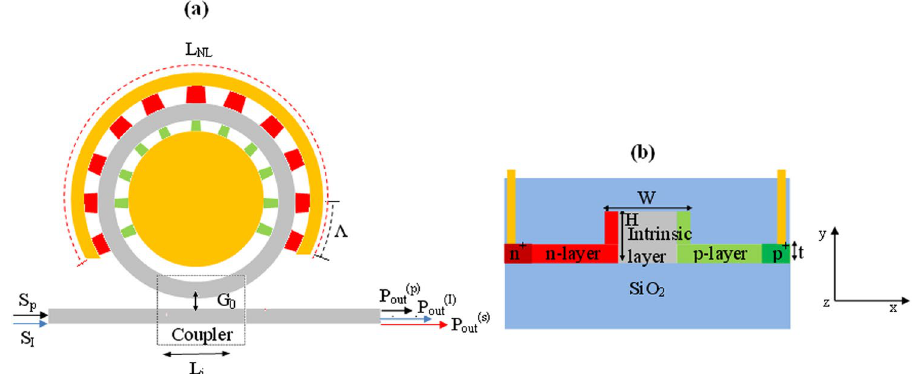
Figure 1. ( a ) Schematic of an integrated microring resonator inducing the EFIM process. The dashed box evidences the evanescent coupler (EC). The dimensions are not to scale. ( b ) Waveguide cross-section based on SOI technology platform. The high DC E x -field is present in the intrinsic waveguide